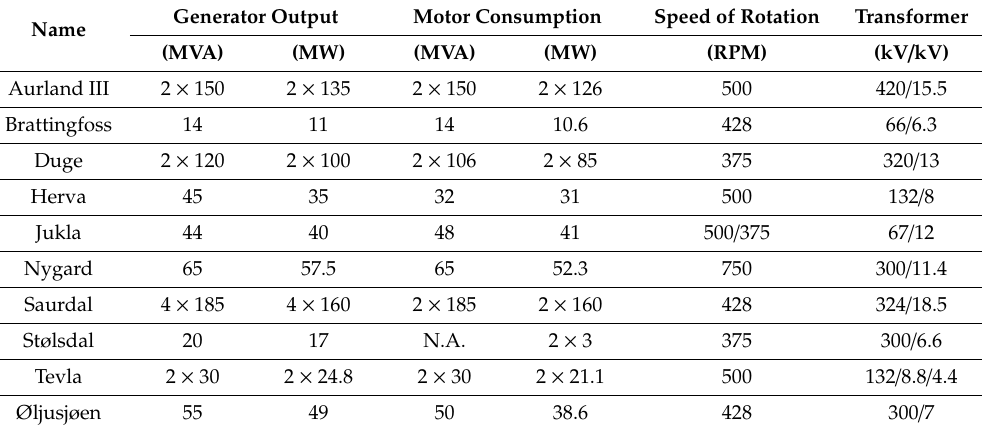
Table 5. Overview of electrical equipment in Norwegian